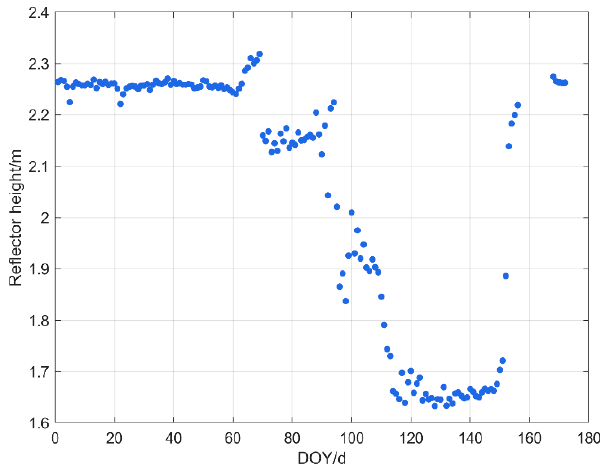
Figure 6. The reflector height of the GPS L1 band.